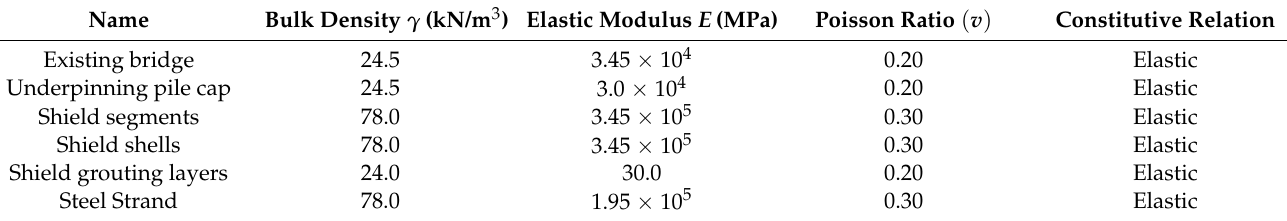
Table 2. Physical and mechanical properties of